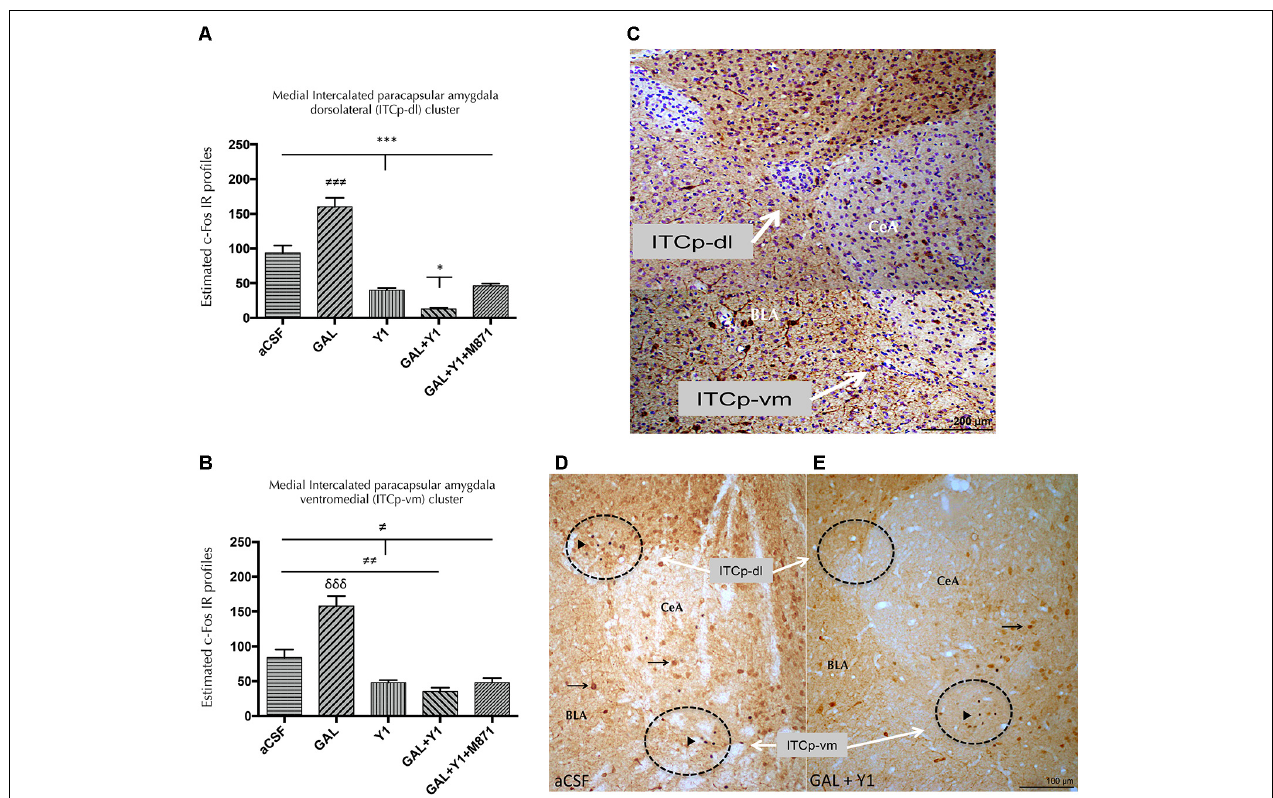
FIGURE 4 | Effects of Galanin (GAL) and NPYY1R agonist, alone in combination or together with the GAL 2 receptor (GALR2) antagonist M871 on c-Fos expression in the medial intercalated paracapsular amygdaloid (ITCp) islands. Quantification of total c-Fos IR nuclei on ITCp, in dorsolateral (ITCp-dl) (A) and ventromedial (ITCp-vm) (B) clusters. Data, expressed as mean ± SEM show the differences between groups after the icv injection of aCSF, GAL, NPYY1 agonist [Leu 31 -Pro 34 ]NPY, or the coadministration of both peptides and M871. (A) The coadministration of GAL and NPYY1 agonist decreased c-Fos expression specifically in the ITCp-dl as compared with the effects both peptides alone and the aCSF group. Moreover, the effects of GAL and NPYY1 agonist coadministration were counteracted by the GALR2 antagonist M871. (B) The administration of the NPYY1 agonist decreased the c-Fos expression in the ITCp-vm in a similar way compared including its combination with GAL. ∗ P < 0.05; ∗∗∗ P < 0.001; (cid:54)= P < 0.05; (cid:54)=(cid:54)= P < 0.01; (cid:54)=(cid:54)=(cid:54)= P < 0.001; δδδ P < 0.001 according to one-way ANOVA followed by Newman–Keuls Multiple Comparison Test. Inter-group comparisons are indicated by the lines above bars. N = 4 in each group. (C) Digital photo-montage illustrating the analyzed ITCp dorsolateral (ITCp-dl) and ventromedial (ITCp-vm) clusters located between basolateral (BLA) and central (CeA) amygdaloid nucleus [Bregma: –2.3 mm; according to the Paxinos and Watson (1986) stereotaxical atlas]. Sections were double immunostained with Calbindin and counterstained with cresyl violet. The coadministration of GAL and NPYY1R agonist is illustrated to decrease the c-Fos expression especially in non-calbindinergic neurons specifically in the ITCp-dl compared with the control group (D,E) . White arrows indicate ITC-dl and ITCp-vm cell clusters. Black arrowheads indicate neurons that are c-Fos+/Calbindin-; black arrows indicate neurons that are c-Fos-/Calbindin+. Dashed circles represent measuring fields. Abbreviations: